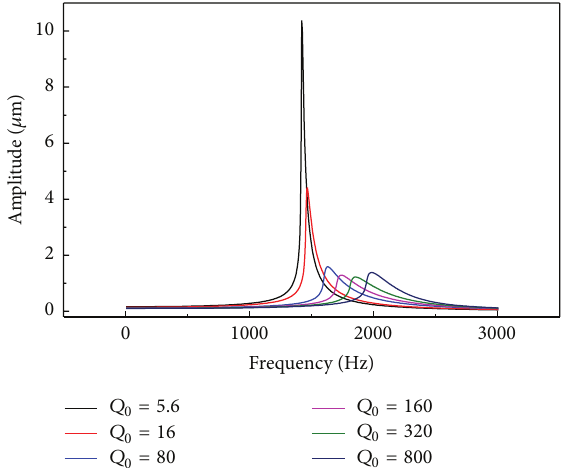
Figure 6: Vibration response of dry friction blade 𝑚 2 with